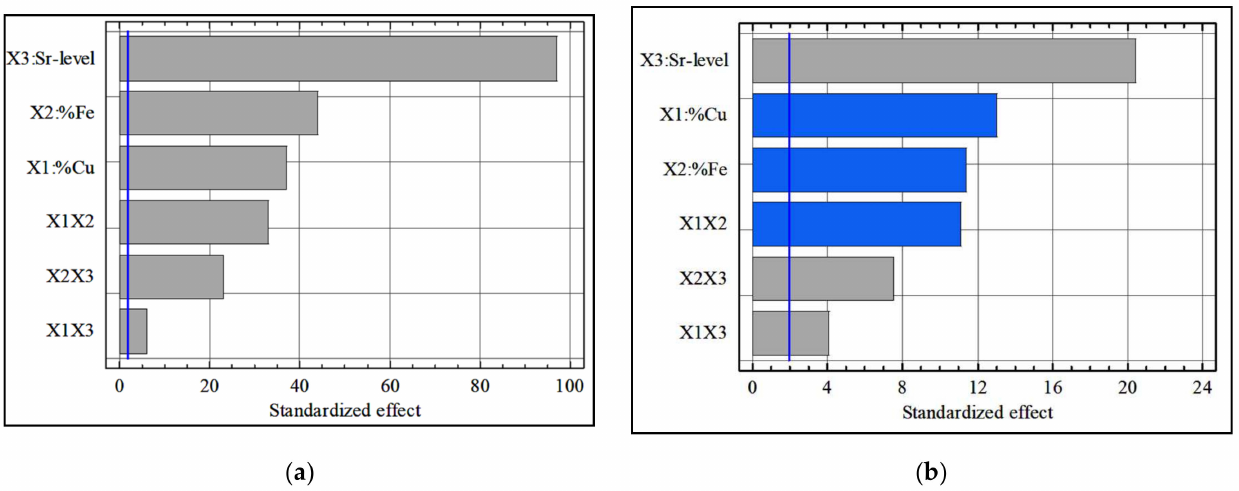
Figure 6. Pareto charts of the standardized effects for ( a ) total cutting force data and ( b ) cutting power data.